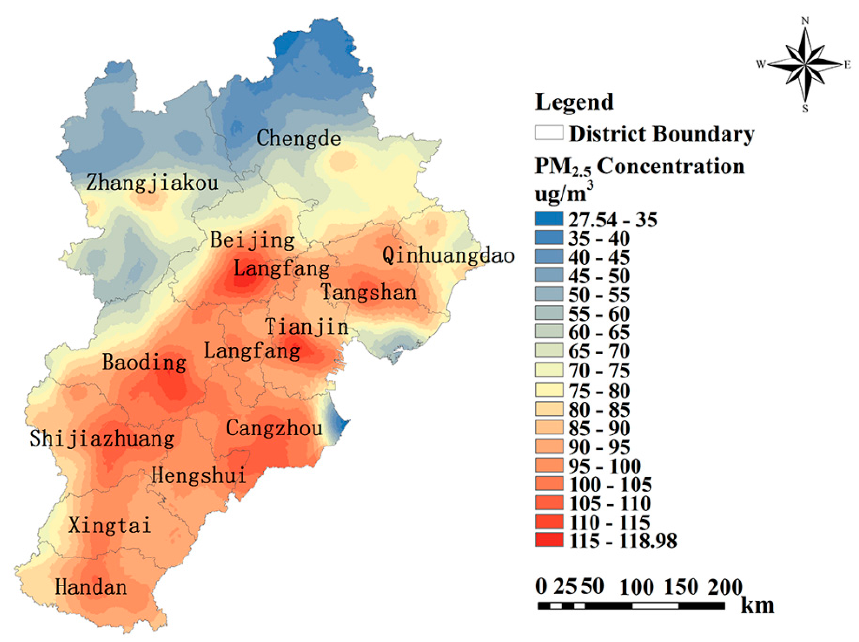
Figure 7. Spatial distributions of estimated PM 2.5 concentrations.